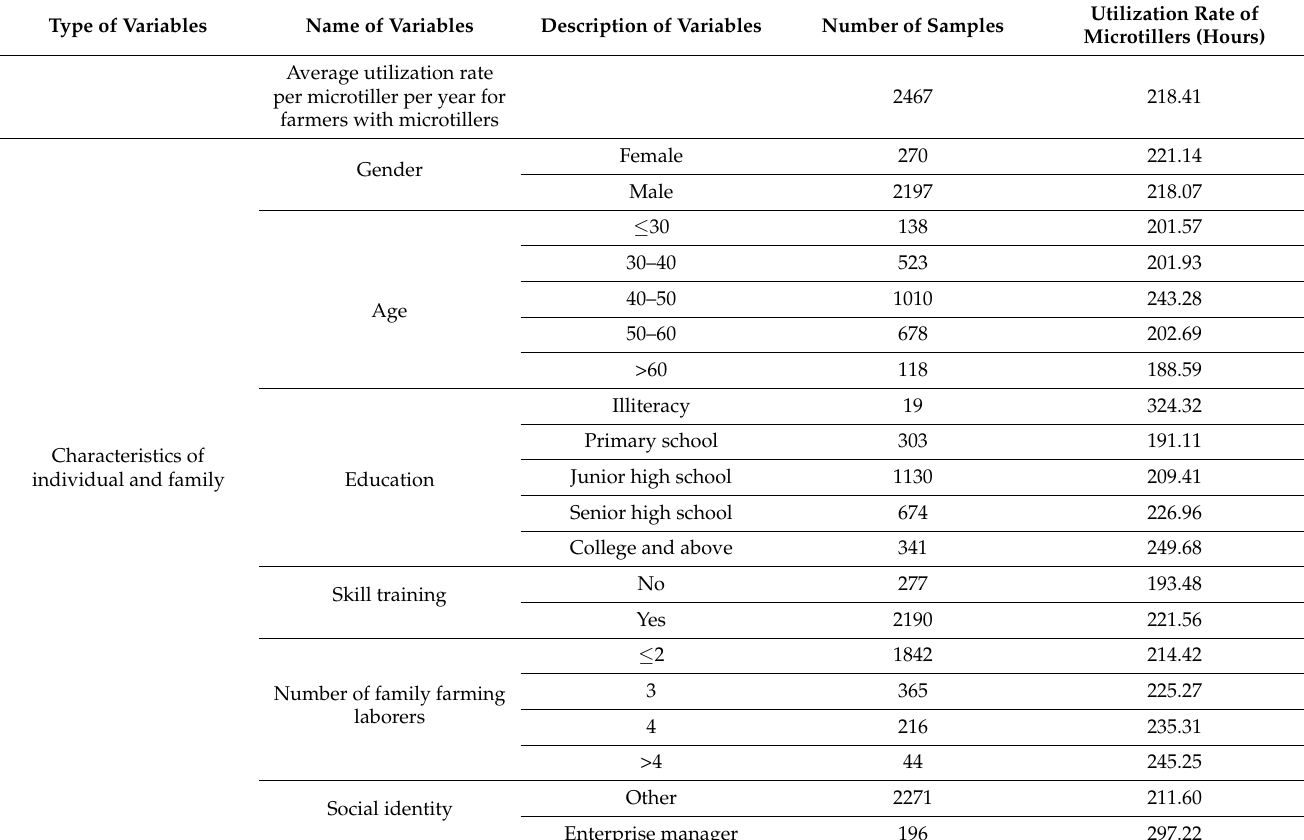
Table A1. Results for